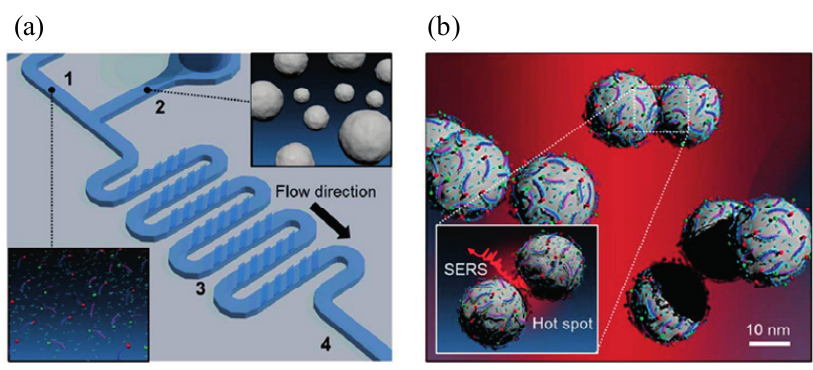
Figure 10. ( a ) Microfluidic channel for mixing of (1) DNA oligomer mixtures and (2) silver nanoparticles. The (3) groove structure is designed to increase the efficiency of the mixing on the microfluidic channel and SERS signal is detected in the (4) downstream region ( b ) SERS signal coming from DNA oligomer on silver nanoparticles when hot